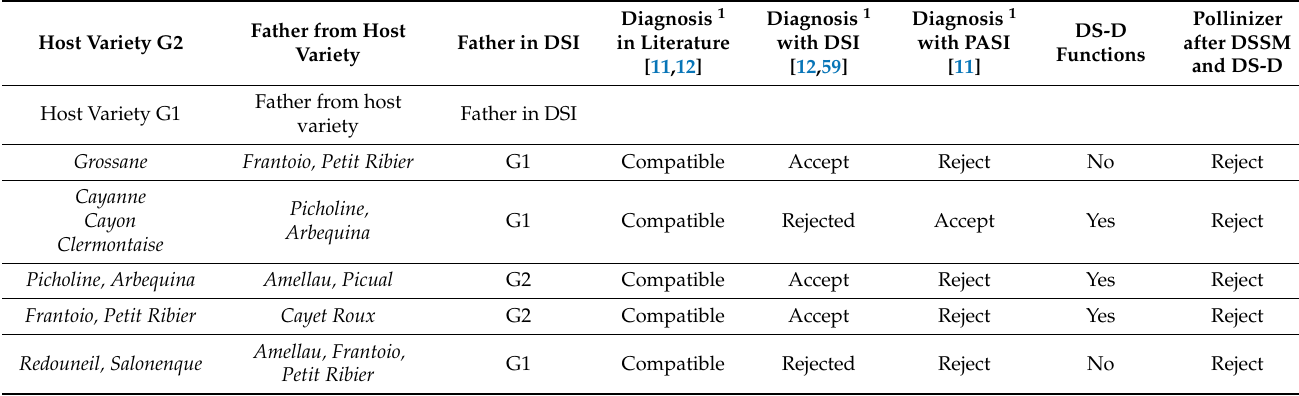
( a ) ( b ) Figure 6. Temporal schemes of the events following pollination ( a ) with compatible pollen within four days, DSI acts, then PASI, leading to 0 ‐ 0 and 1 ‐ 0; ( b ) without compatible pollen after 5 to 10 days, DS ‐ D runs for PASI pollen determinants (R1 to R35), leading to pollen tube growth even when incompatible with ovary, but depending upon the S ‐ allele pair in PASI. The length of the blue arrows indicates that the pollen tube growth in selfing is proportional to the risk of DS ‐ D. Pictures are from Adela Olmedilla (Granada, Spain, with permission). Recently, locus G was mapped in olive linkage group 18 [61], and located on the wild olive genome [56]. Based on the archaeploid model, it can be predicted that PASI will be mapped on the homologous linkage group of LG 18. Functional divergence between sub ‐ genomes following genome duplication is a documented evolutionary mechanism that could explain how two variant systems for SI maintain and function in the olive tree [62]. 4. Analyses of Methods and Results from Literature Varieties names provided in Tables 1 and 2 were extracted from publications dealing with olive cross studies. The database OlSiFaComp was constructed with the variety name of origin in the publication in lines [63]. For each variety, one line corresponds to one bag notations, one open pollination observation, or to one pollen experiment. Thus, for one variety, the repeatability of data in selfing and crosses is immediately available in the table. On 28 May 2021, the table displays 6146 lines. For each line, the original data from the publication are reported in columns. Readers will find in each publication the details